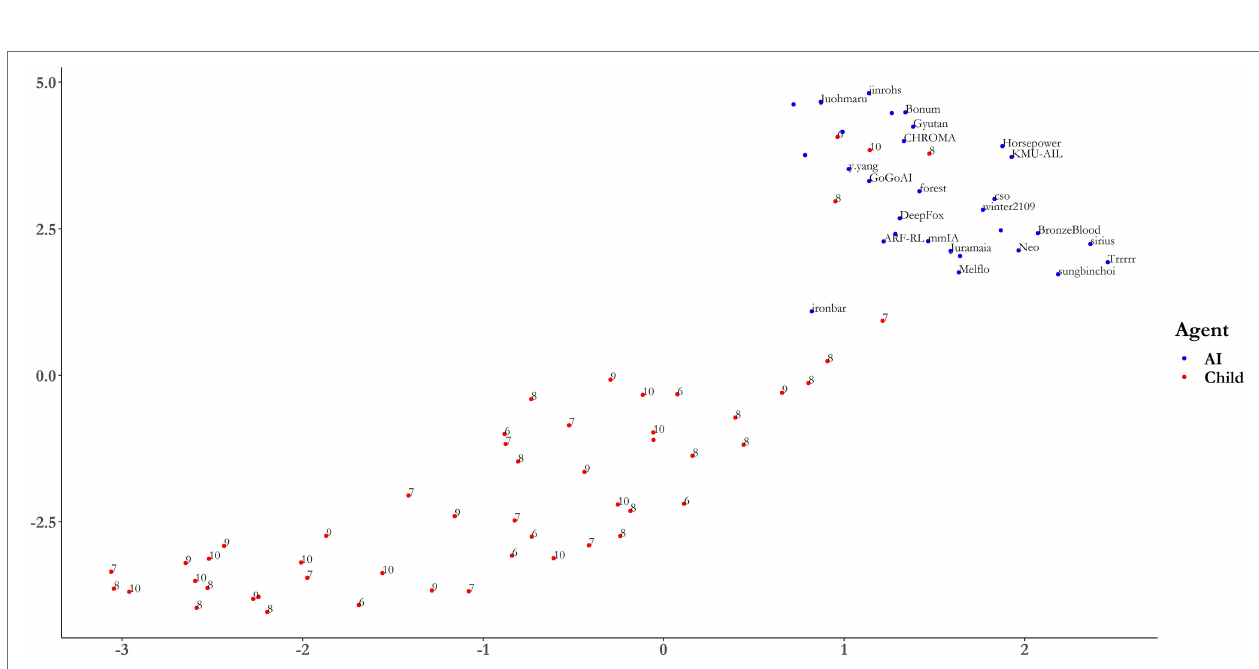
FIGURE 5 | Boxplots of average accuracy on each level, by age/agent type. The left hand 5 boxplots for each level are the age groups 6–10 respectively, with the rightmost boxplot being the AI group. The green bars show the average pass mark for each